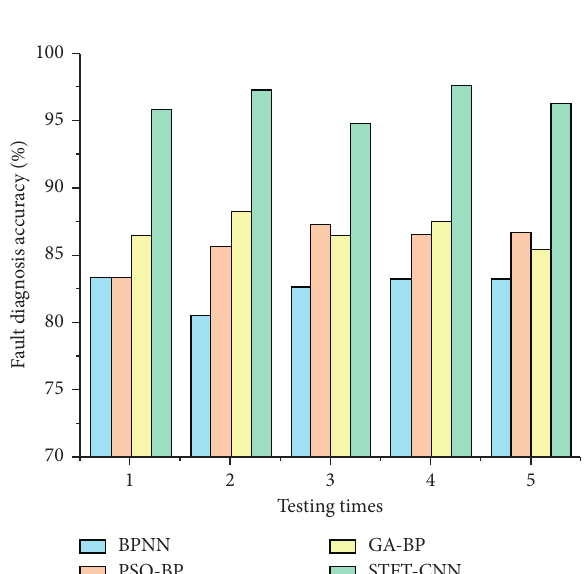
Figure 14: Training and testing processes.